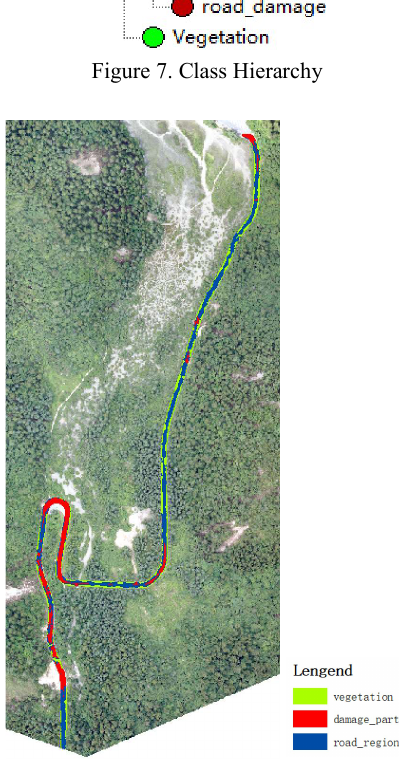
Figure 8. Exported Vector Layer